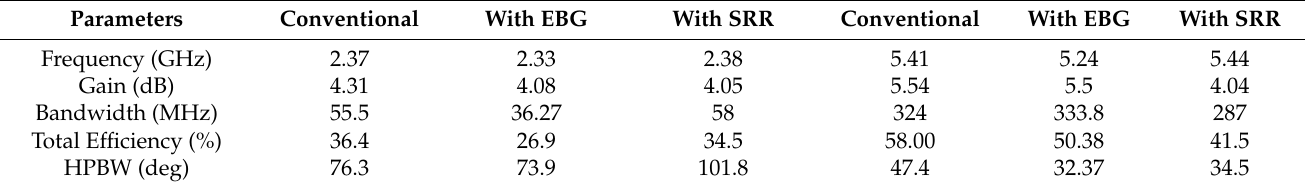
Table 6. Summary of results (conventional vs. EBG-based vs. SRR-based) bent antennas in free